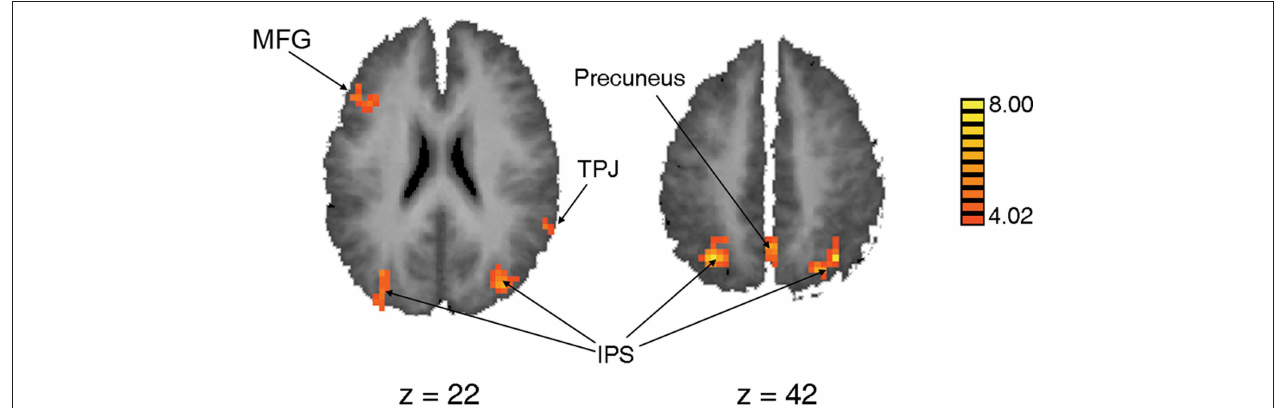
FIguRe 7 | Statistical map of regions that are more active for Distractor Present trials than Distractor Absent trials, projected onto a group-average Talairach brain; see Table 3 for size and coordinates.